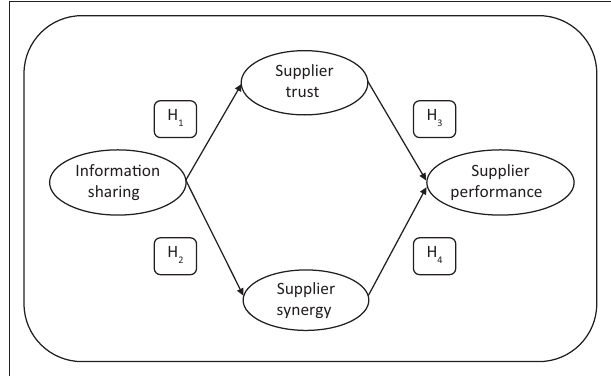
FIGURE 1: Conceptual